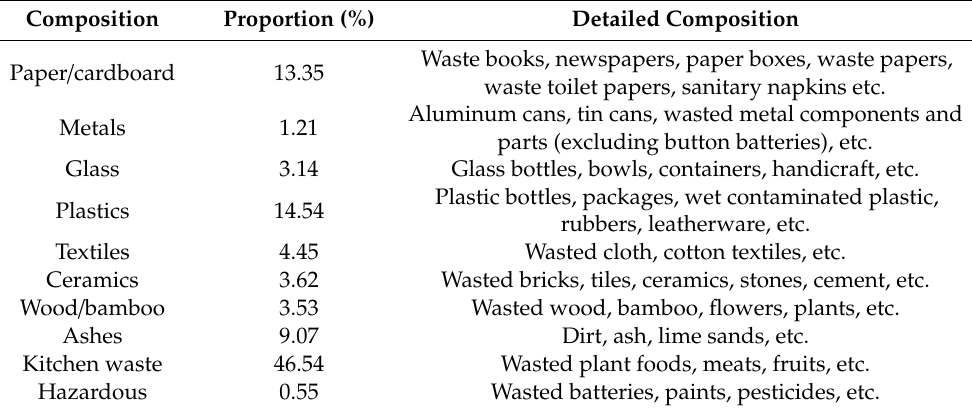
Table 1. Compositions of mixed municipal solid waste (MSW) in China [70,73–76]. Composition Proportion (%) Detailed Composition Waste books, newspapers, paper boxes, waste papers, Paper / cardboard 13.35 waste toilet papers, sanitary napkins